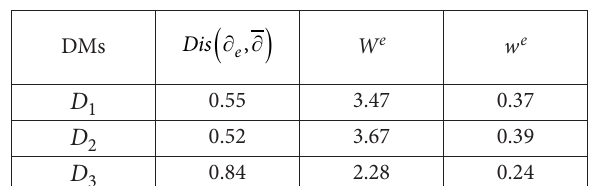
Table 6. Weights of the DMs